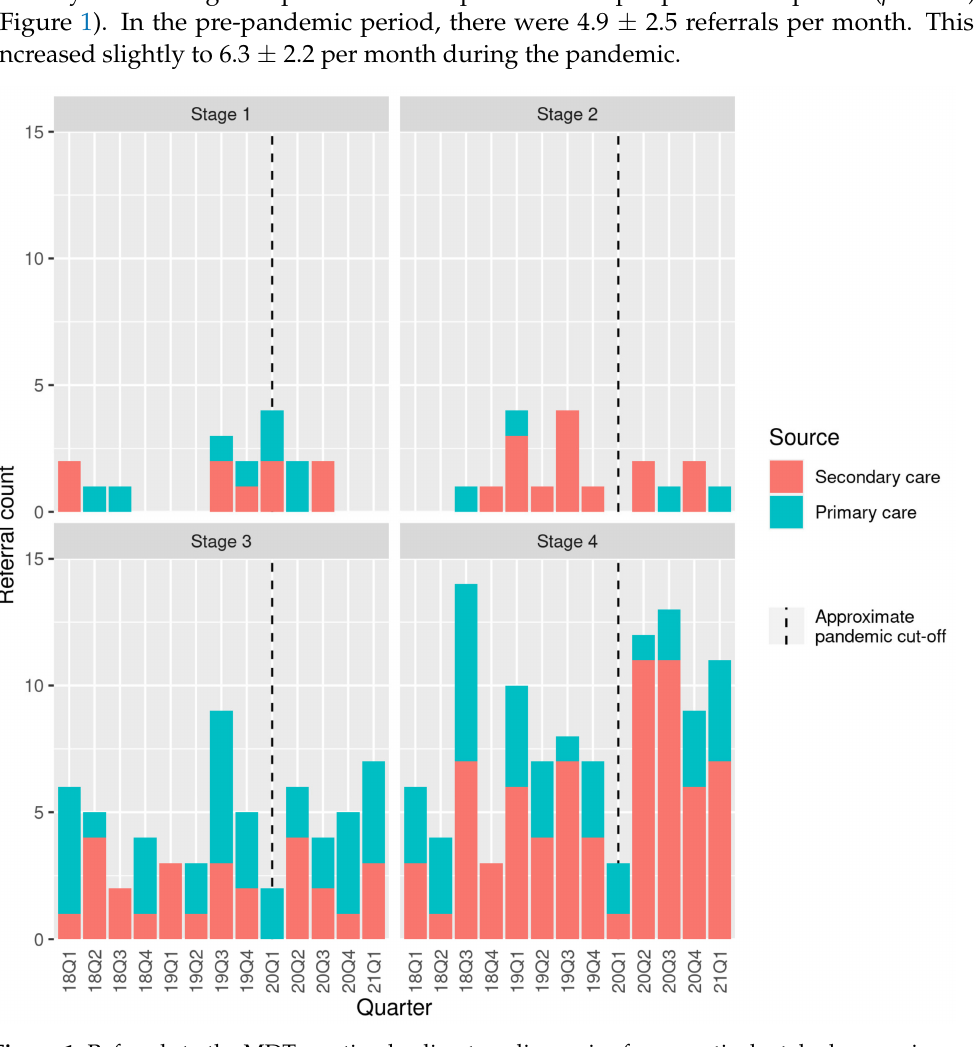
Figure 1. Referrals to the MDT meeting leading to a diagnosis of pancreatic ductal adenocarcinoma (PDAC) stratified by disease stage at